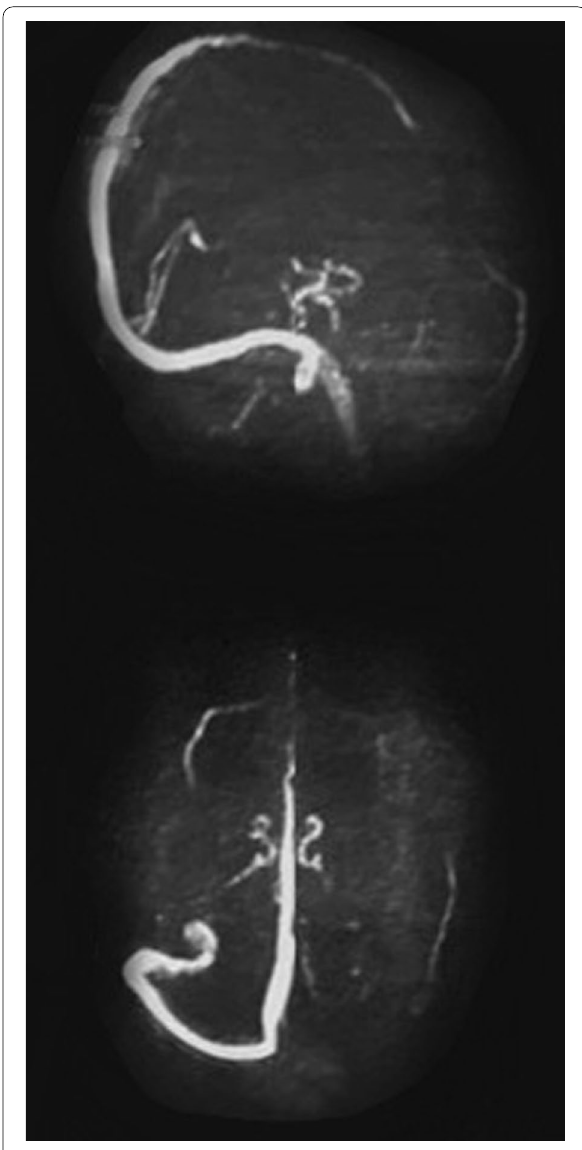
Fig. 3 Left lateral dural venous sinuses thrombosis and deep vein thrombosis as evident through